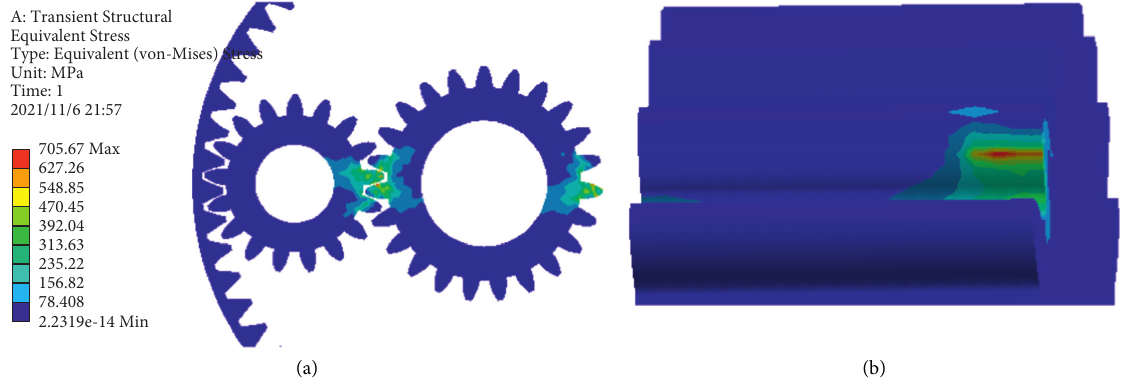
Figure 16: Program of equivalent stress of the planetary gear train. (a) Equivalent stress program. (b) Program of sun gear stress.